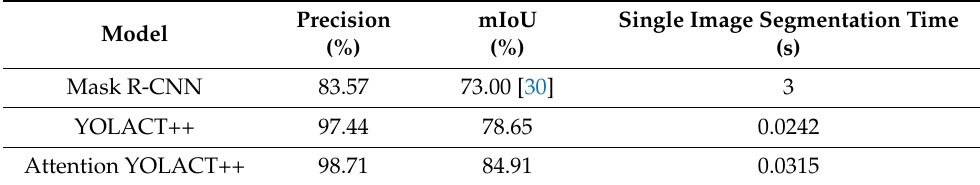
Table 2. Comparison of segmentation performance of different models.